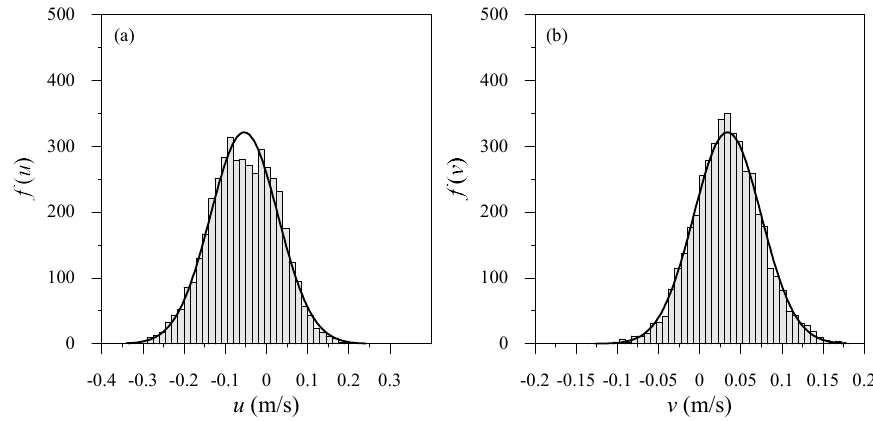
Figure 9. Comparisons of the measured flow velocities and fitted normal distributions for Run S-2 ( T = 15 min): ( a ) u and ( b ) v .